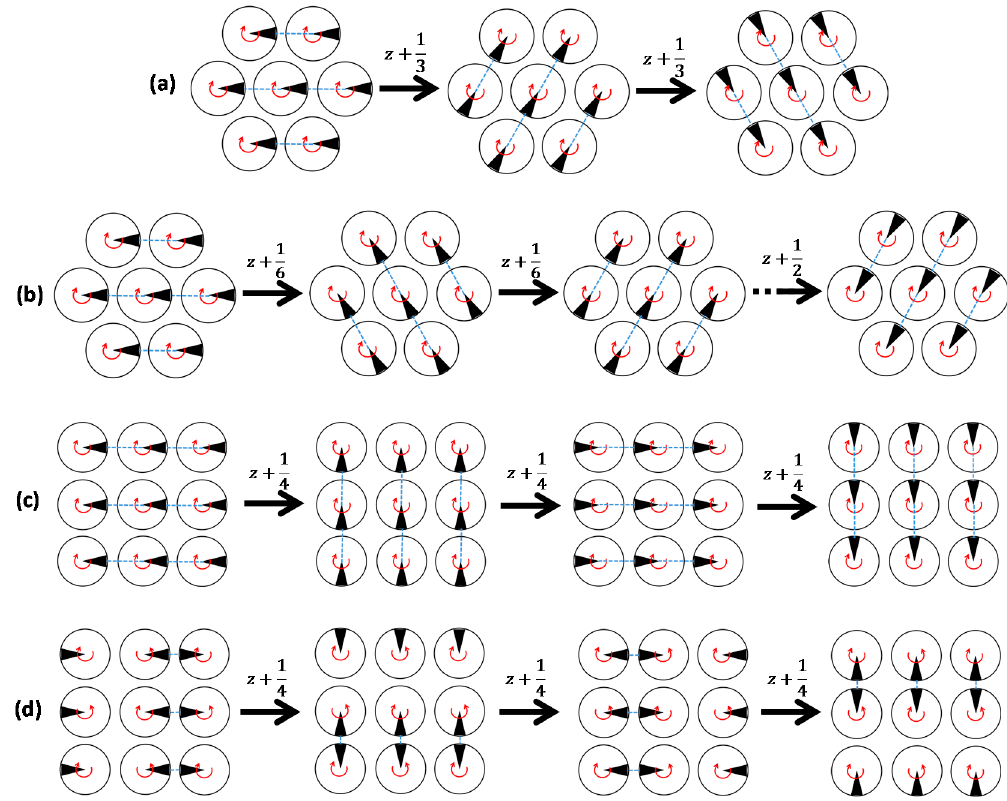
Figure 1. Representation of examples of packings for ( a ) a chiral assembly of 3 n helices in hexagonal arrangement, ( b ) a chiral assembly of 6 n helices in hexagonal arrangement, ( c ) a chiral assembly of 4 n helices in tetragonal arrangement, ( d ) a non-chiral assembly of 4 n helices in tetragonal arrangement. The red arrows and black triangles represent the handedness of helices and the helicates, respectively. In order to be symmetrically equivalent, the helicates must have the same environment.